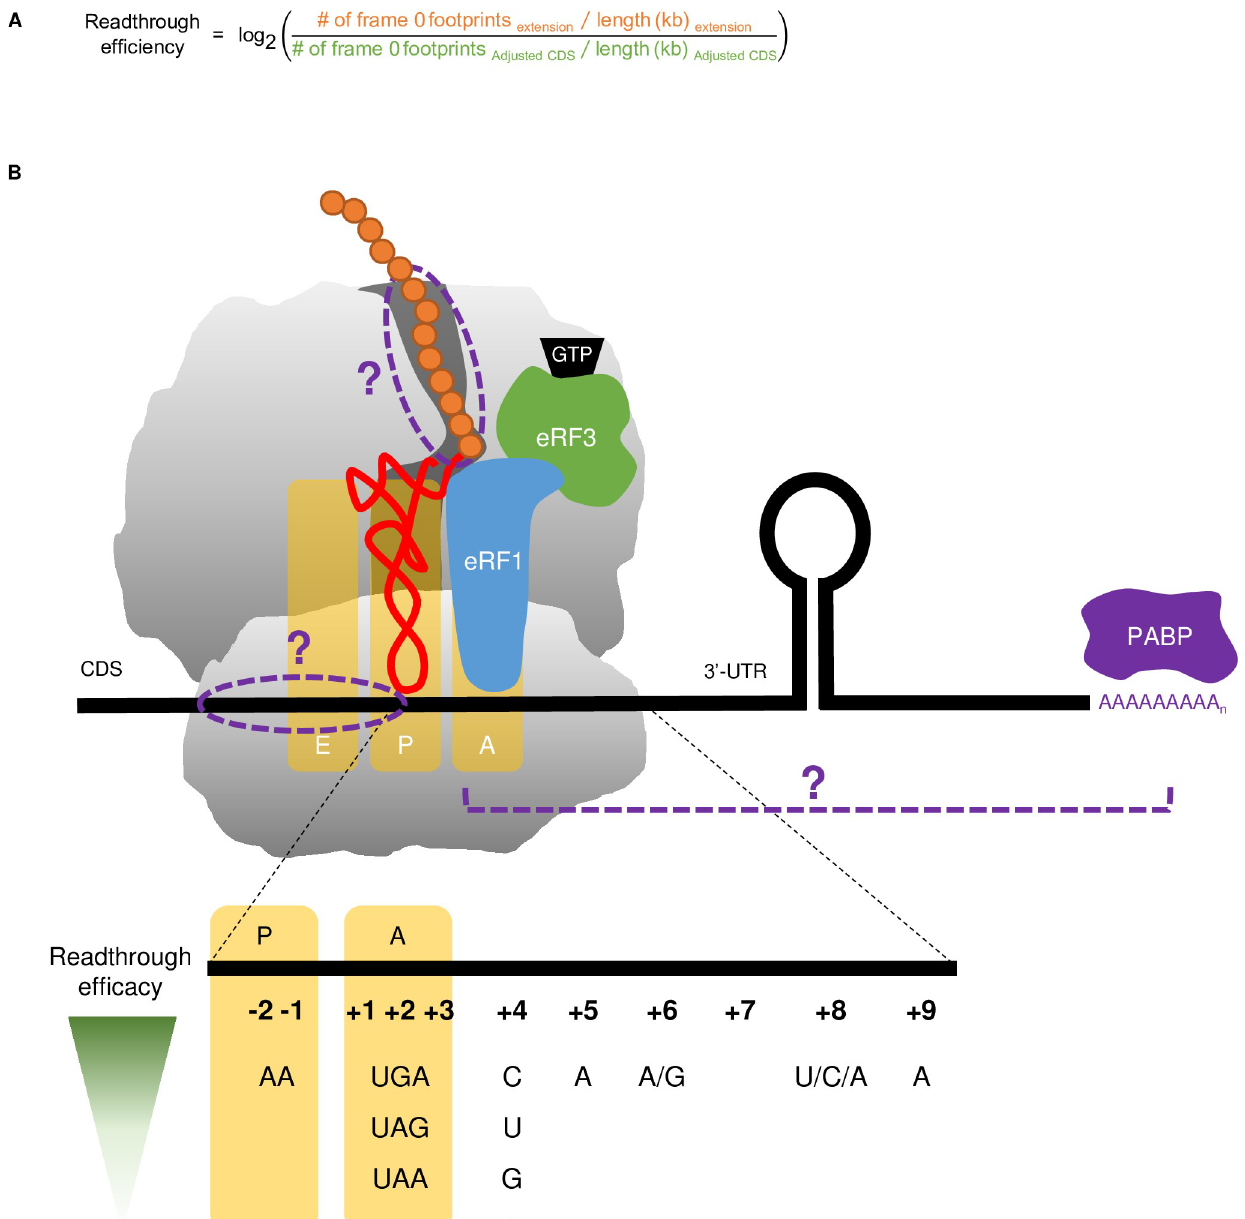
Fig 3. Definition of X and Y Variables. A. Readthrough efficiency calculation formula, which takes into account the ribosome pile-up at NTCs and reading frame preference. B. mRNA and nascent peptide features of interest in the context of the ribosome and related translation termination components. Previously identified variables are colored and labeled. Hypothesized variables are in purple and marked with “?”. Details of how each variable is measured are in Table 1. Information regarding the effects of particular nucleotides on readthrough efficacy is taken from a recent review, as is the general format of the schematic